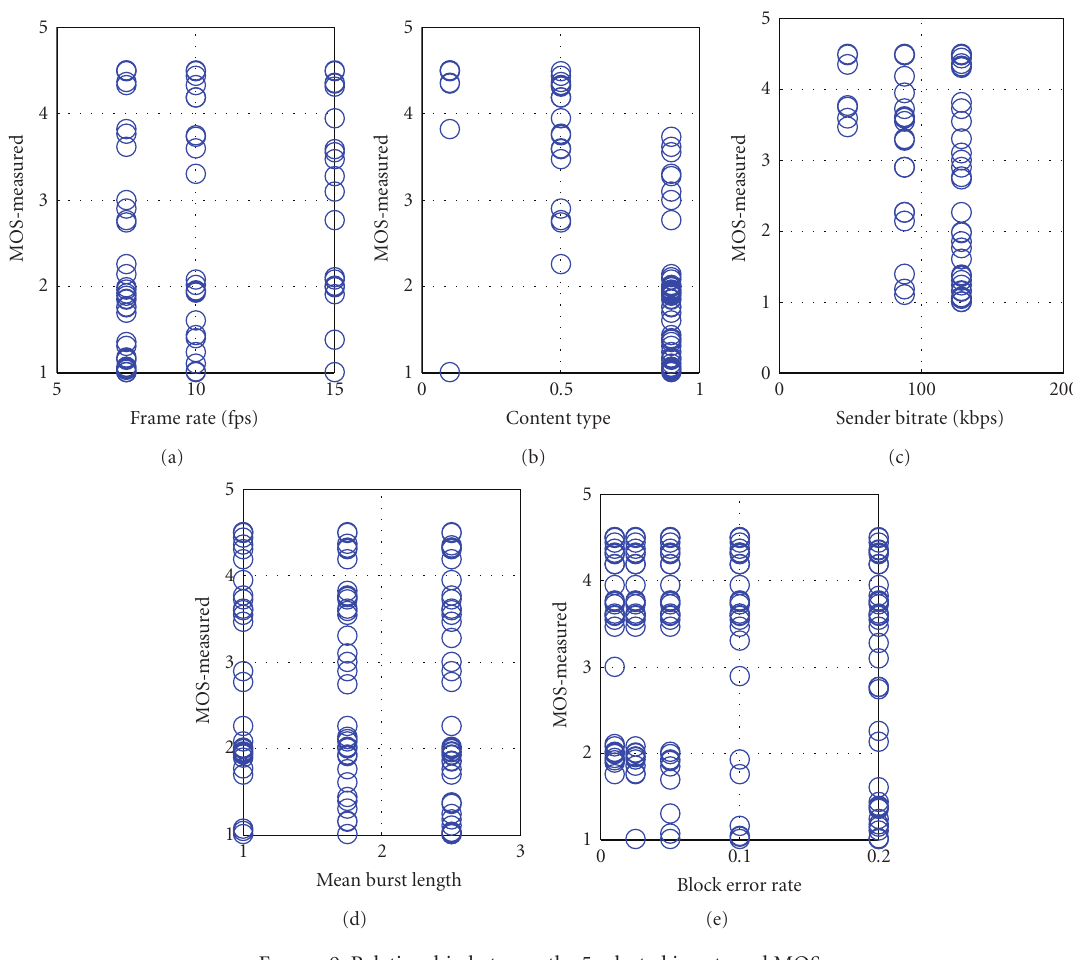
Figure 9: Relationship between the 5 selected inputs and MOS.